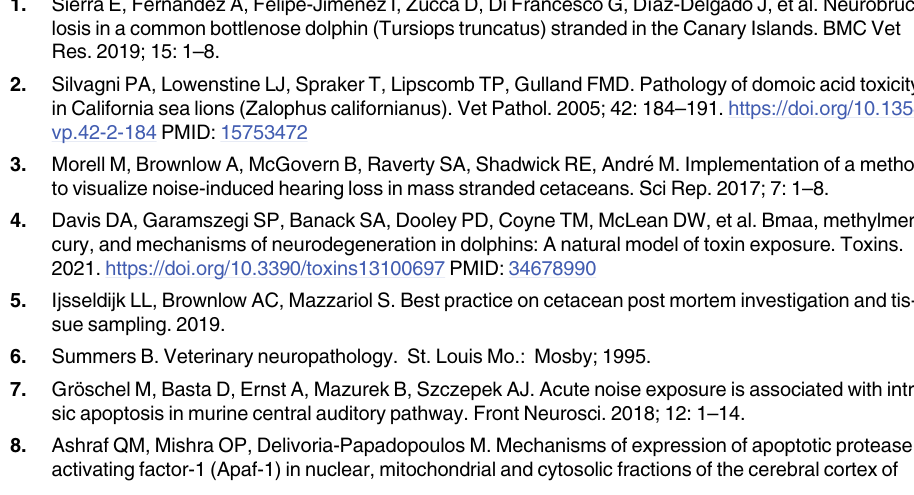
S1 Table. Results of the statistical comparisons of groups made according to A) morpho- pathological findings in haematoxylin-eosin stained sections, B) immunohistochemical findings C) age. In gray—results that do not fit into the parametric/non-parametric category according to results of the Shapiro-Wilks and/or Levene’s tests. If the group differences persist in post-hoc analyses, level of adjustment for α -error are documented. Bf—Bonferroni adjust- ment for α -error. S2 Table. Summary of the ID, sex, body length, full histopathological findings of the CNS, and the most probable cause of death of the dolphins included in this